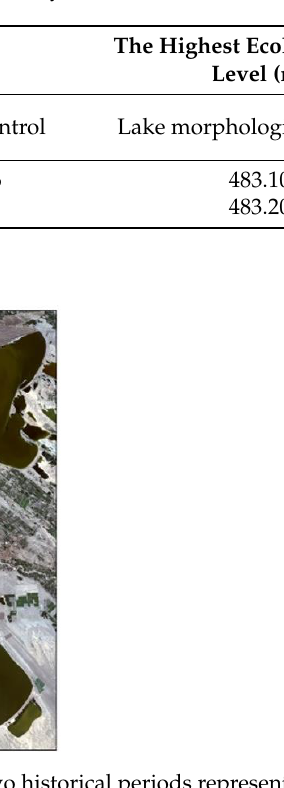
Figure 8. Remote sensing images of Ulungur Lake for two historical periods representing the lowest and highest water levels.